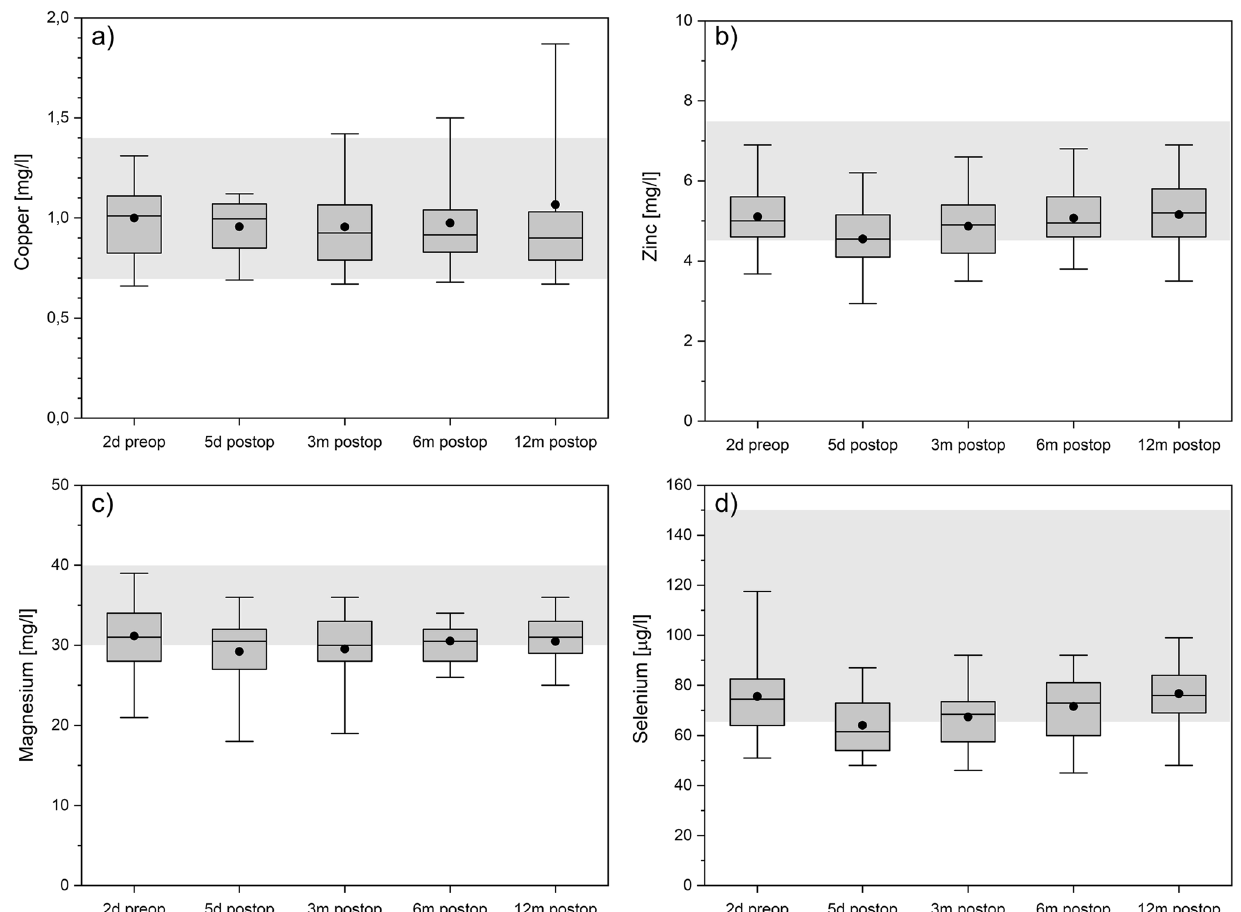
Figure 6. Copper (panel a ), zinc (panel b ), magnesium (panel c ), and selenium (panel d ) over time. The boxes contain the 25% and the 75% quartile as well as the median, black dots depict the mean, and whiskers